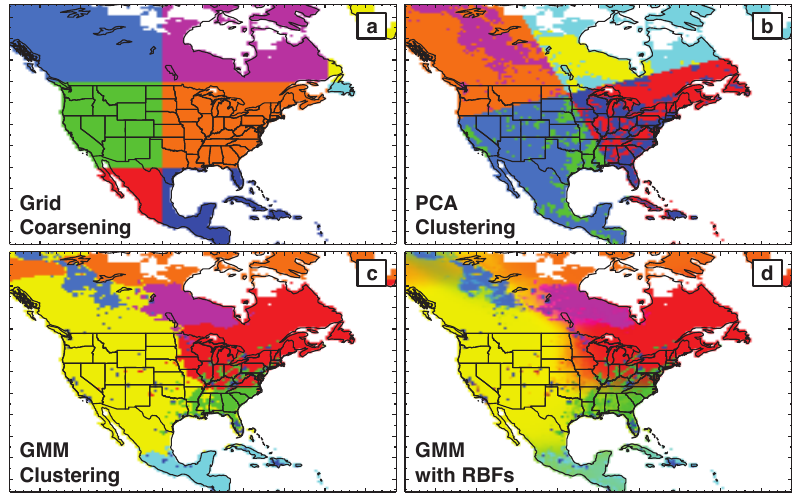
Figure 1. Illustration of different approaches for aggregating a state vector. Here the native-resolution state vector is a field of gridded ◦ ◦ × 2 methane emissions at 1 resolution over North America. Extreme reduction to eight state vector elements is shown with individual 2 3 elements distinguished by